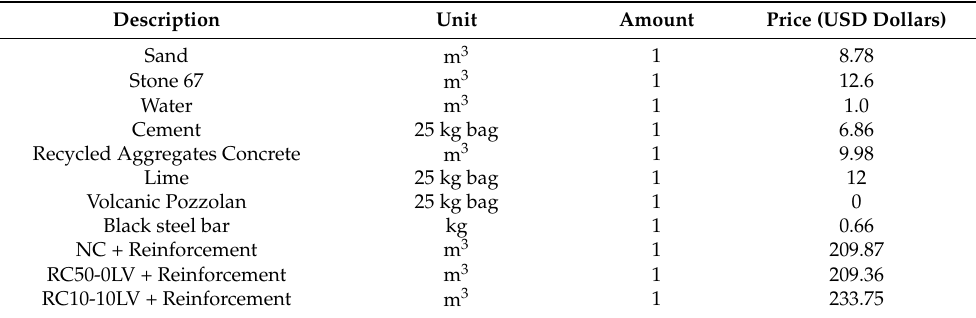
Table 7. Material cost